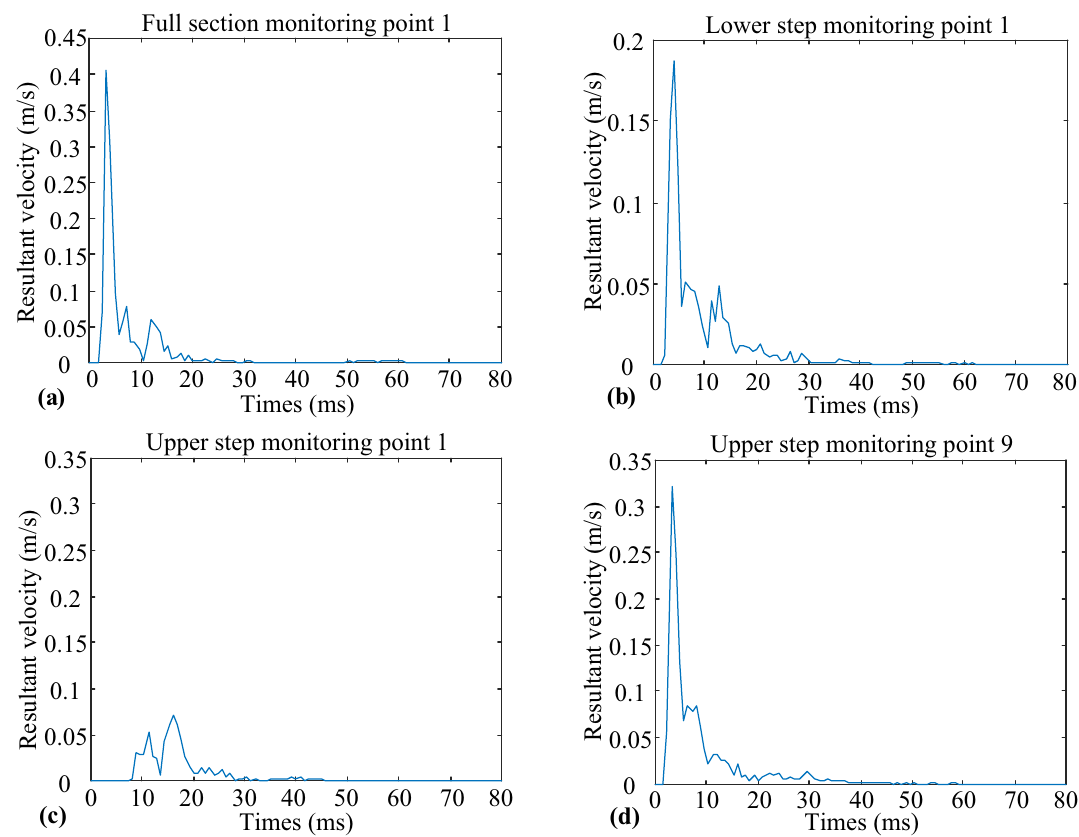
Figure 8. Time course curve of resultant velocity of blast vibration: ( a ) Full section monitoring point 1. ( b ) Lower step monitoring point 1. ( c ) Upper step monitoring point 1. ( d ) Upper step monitoring point 9.